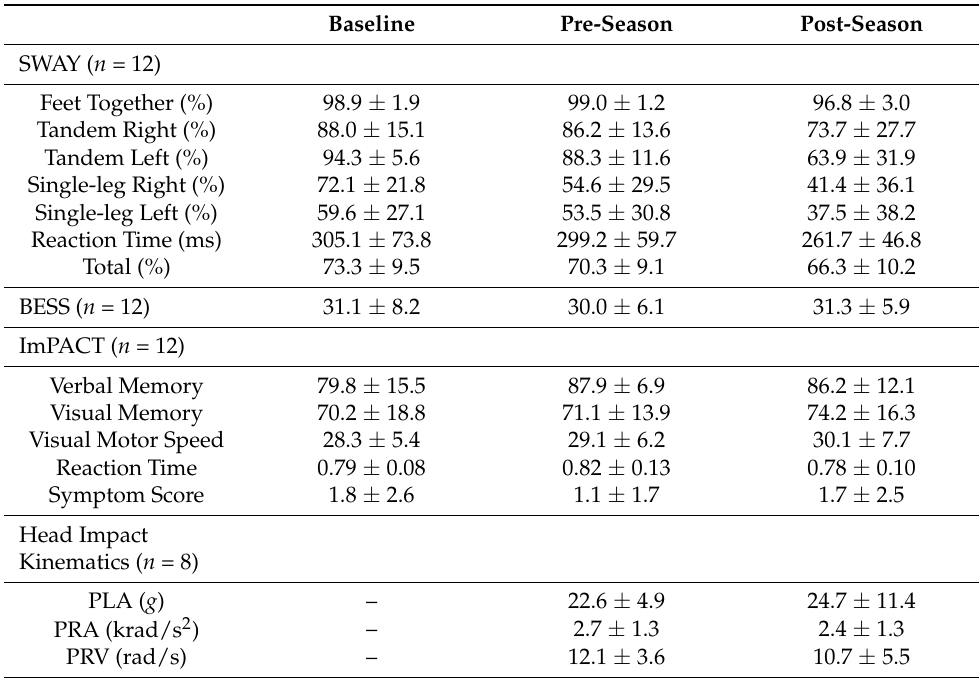
Table 3. Baseline, pre-season, and post-season balance, neurocognitive, and head impact kine- matic